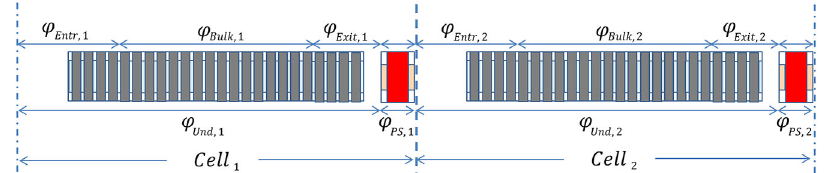
FIG. 1. Definition of the different field regions in two sample undulator